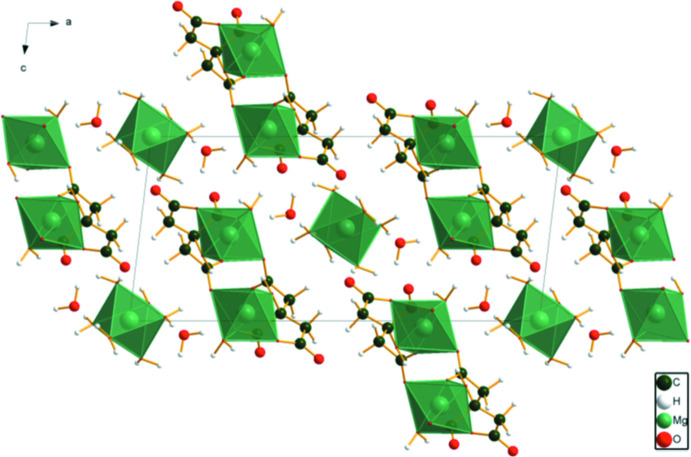
The crystal structure of [Mg(H2O)6][Mg(C6H5O7)(H2O)]2(H2O)2, (MGCITD) viewed down the b axis.